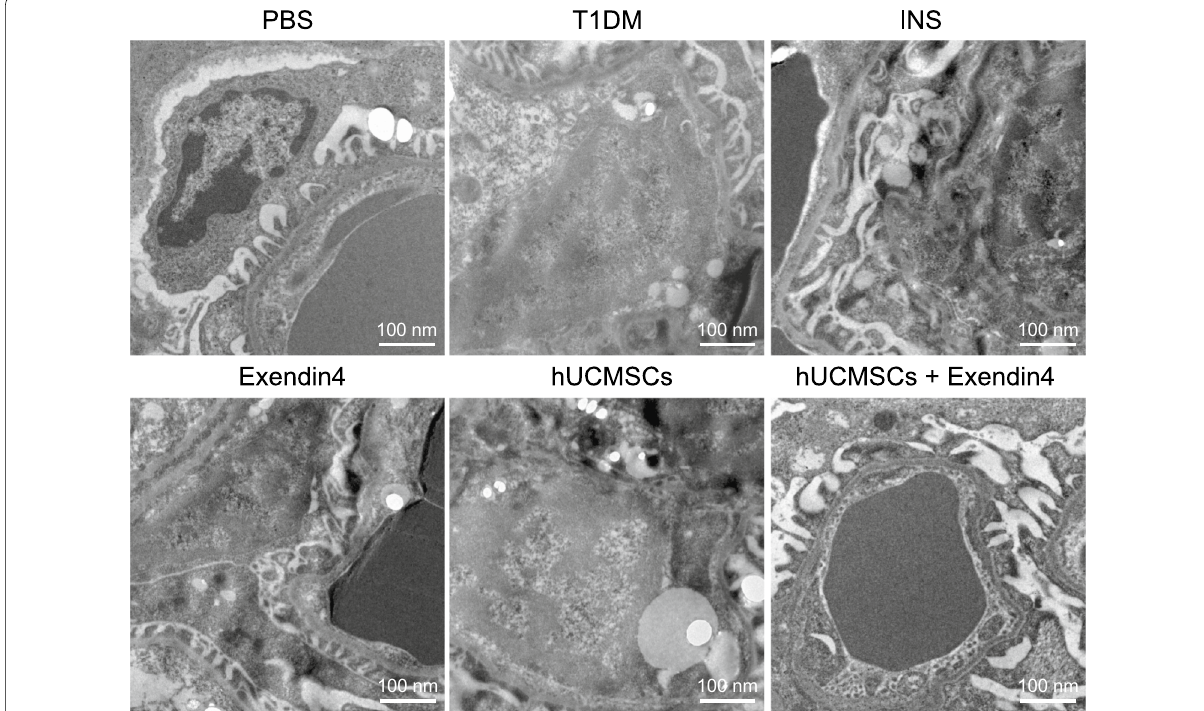
Fig. 3 Changes in kidney tissues of mice with different treatments, observed under a transmission electron microscope (scale bar